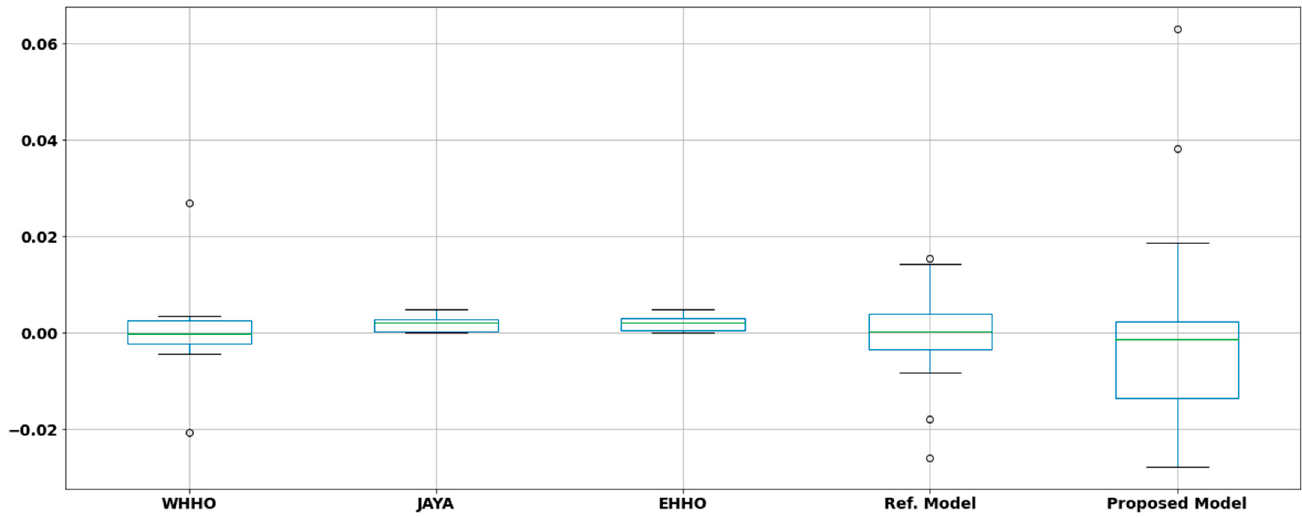
Figure 18. Boxplot of the error in current for the proposed model and other models from the litera- ture (WHHO [14], JAYA [41], and EHHO [40]) compared to the original data regarding the PWM201 model. Table 6. Comparison of the estimated output current for the the proposed methodology and the reference model for the PWM201 modules.